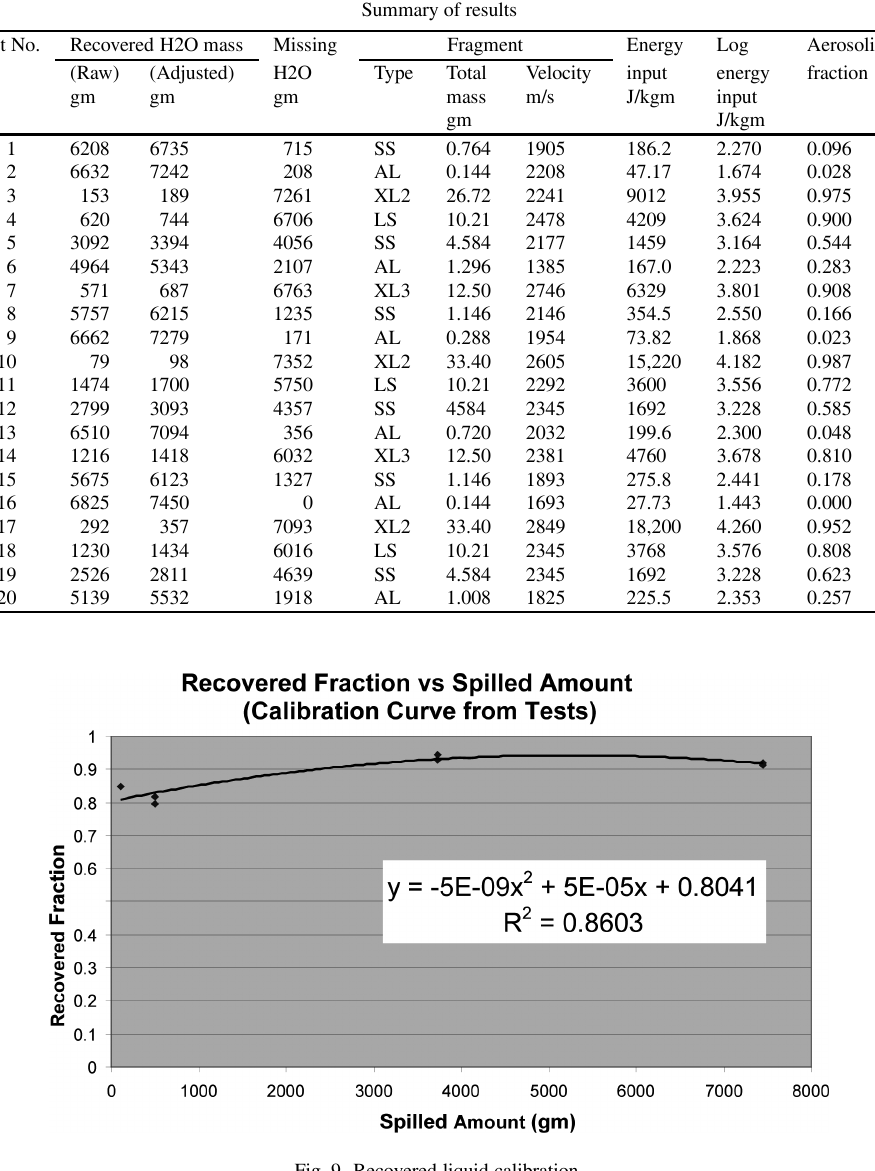
Fig. 9. Recovered liquid